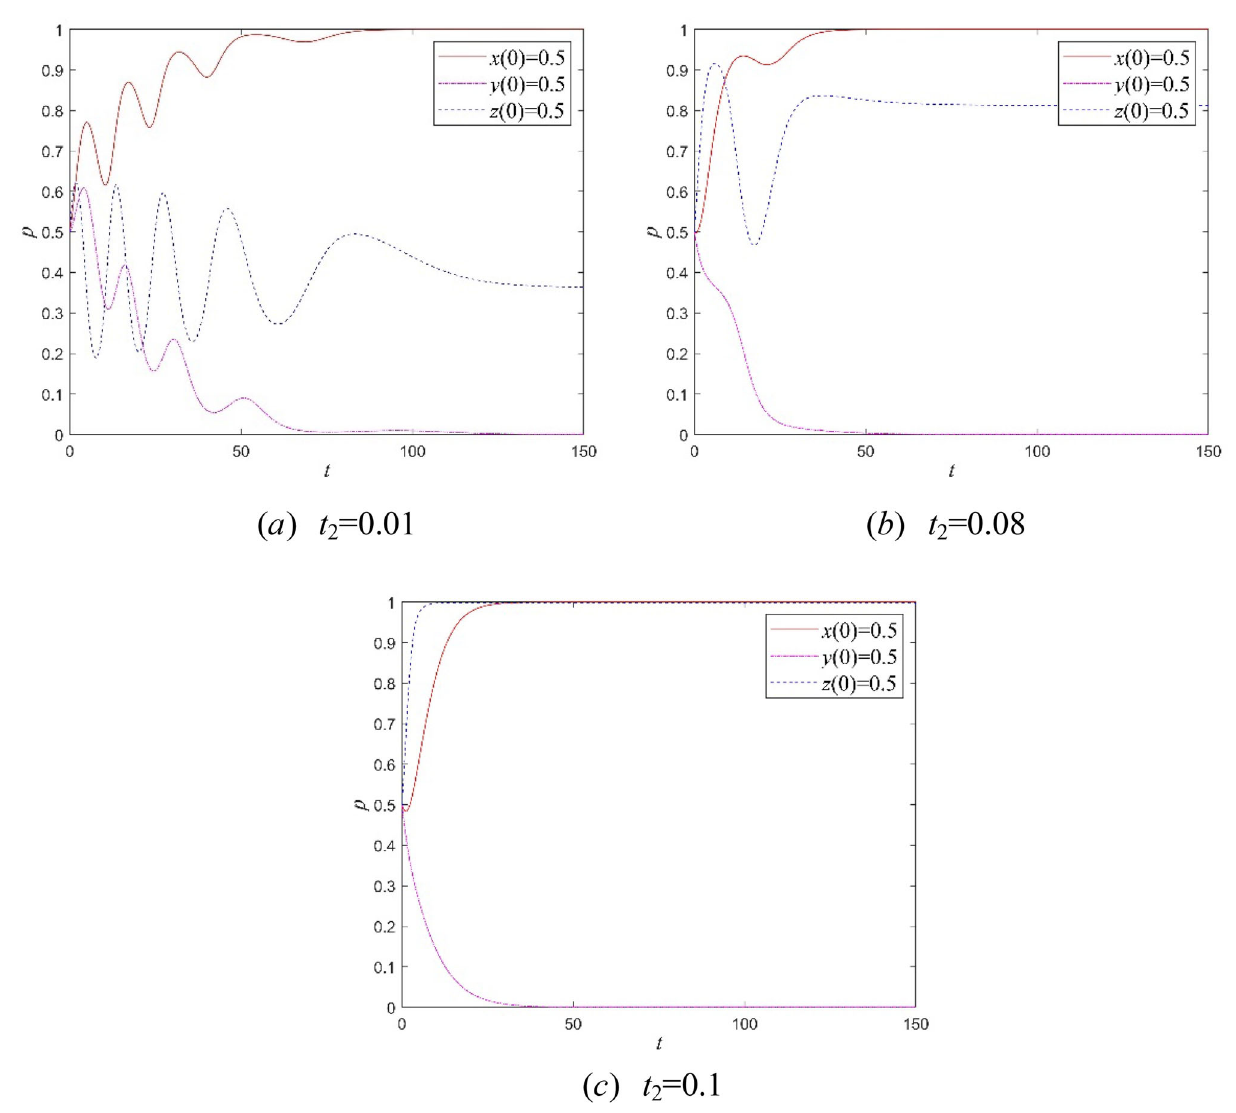
Fig. 6 ( a ) t 2 (cid:2) 0.01, ( b ) t 2 (cid:2) 0.08, ( c ) t 2 (cid:2)